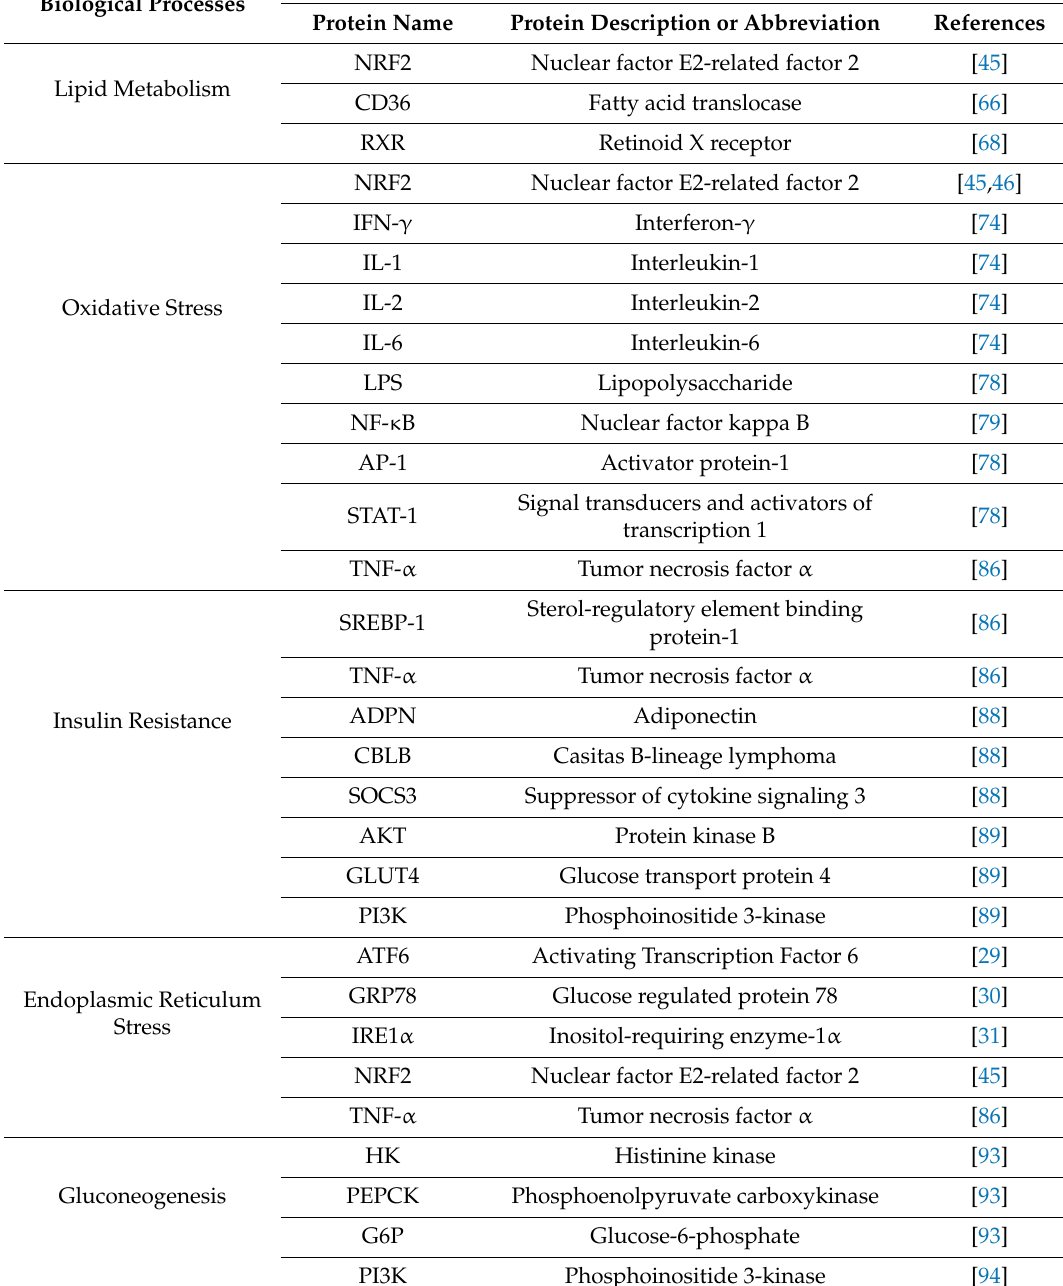
Table A1. Biological processes associated with NAFLD are regulated by PPAR γ through di ff erent signaling factors /